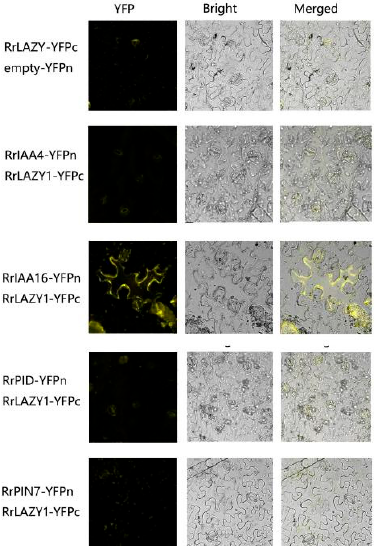
Figure 6. Analysis of protein–protein interactions via yeast two-hybrid experiment between RrLAZY1 and auxin-related proteins of R. rugosa . +++, ++, represent very strong and strong interactions, respectively. − , no interaction.